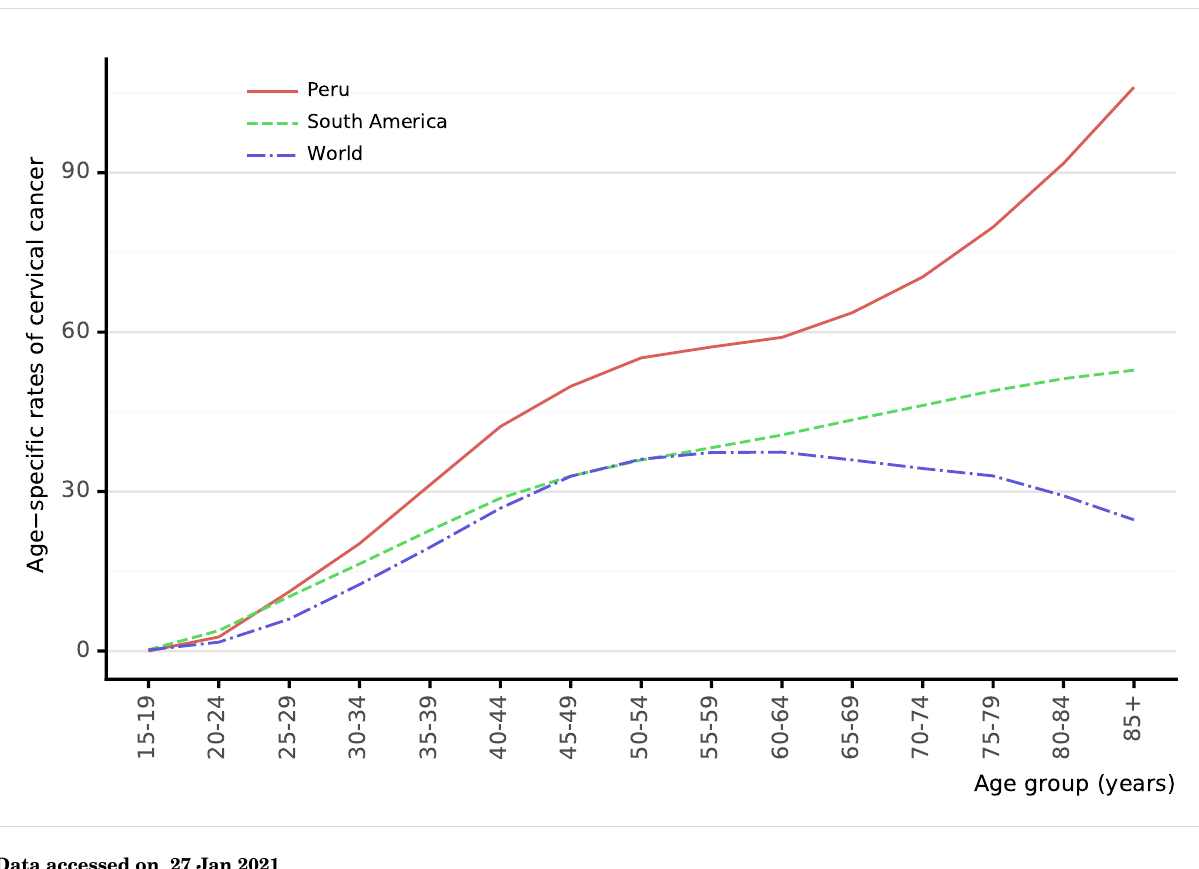
Figure 75: Comparison of age-specific cervical cancer incidence rates in Peru, within the region, and the rest of